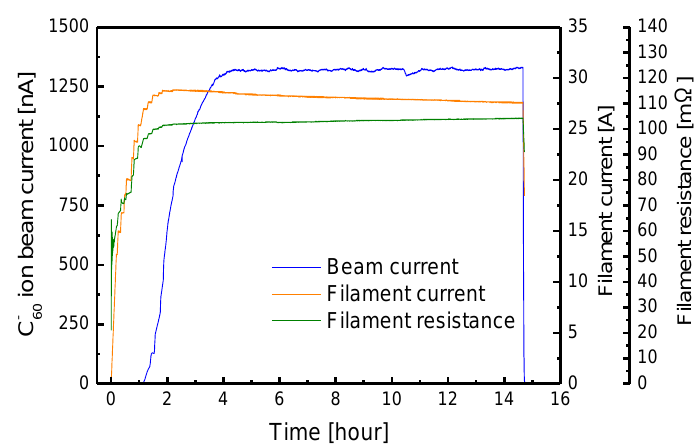
Figure 8. Experimental results for the negative C 60 ion beam production with a C 60 sample containing CsI using an oven rod with a built-in electron source. The blue, orange, and green lines represent the time evolutions of the negative C 60 ion beam current, the filament current, and the filament resistance, respectively.